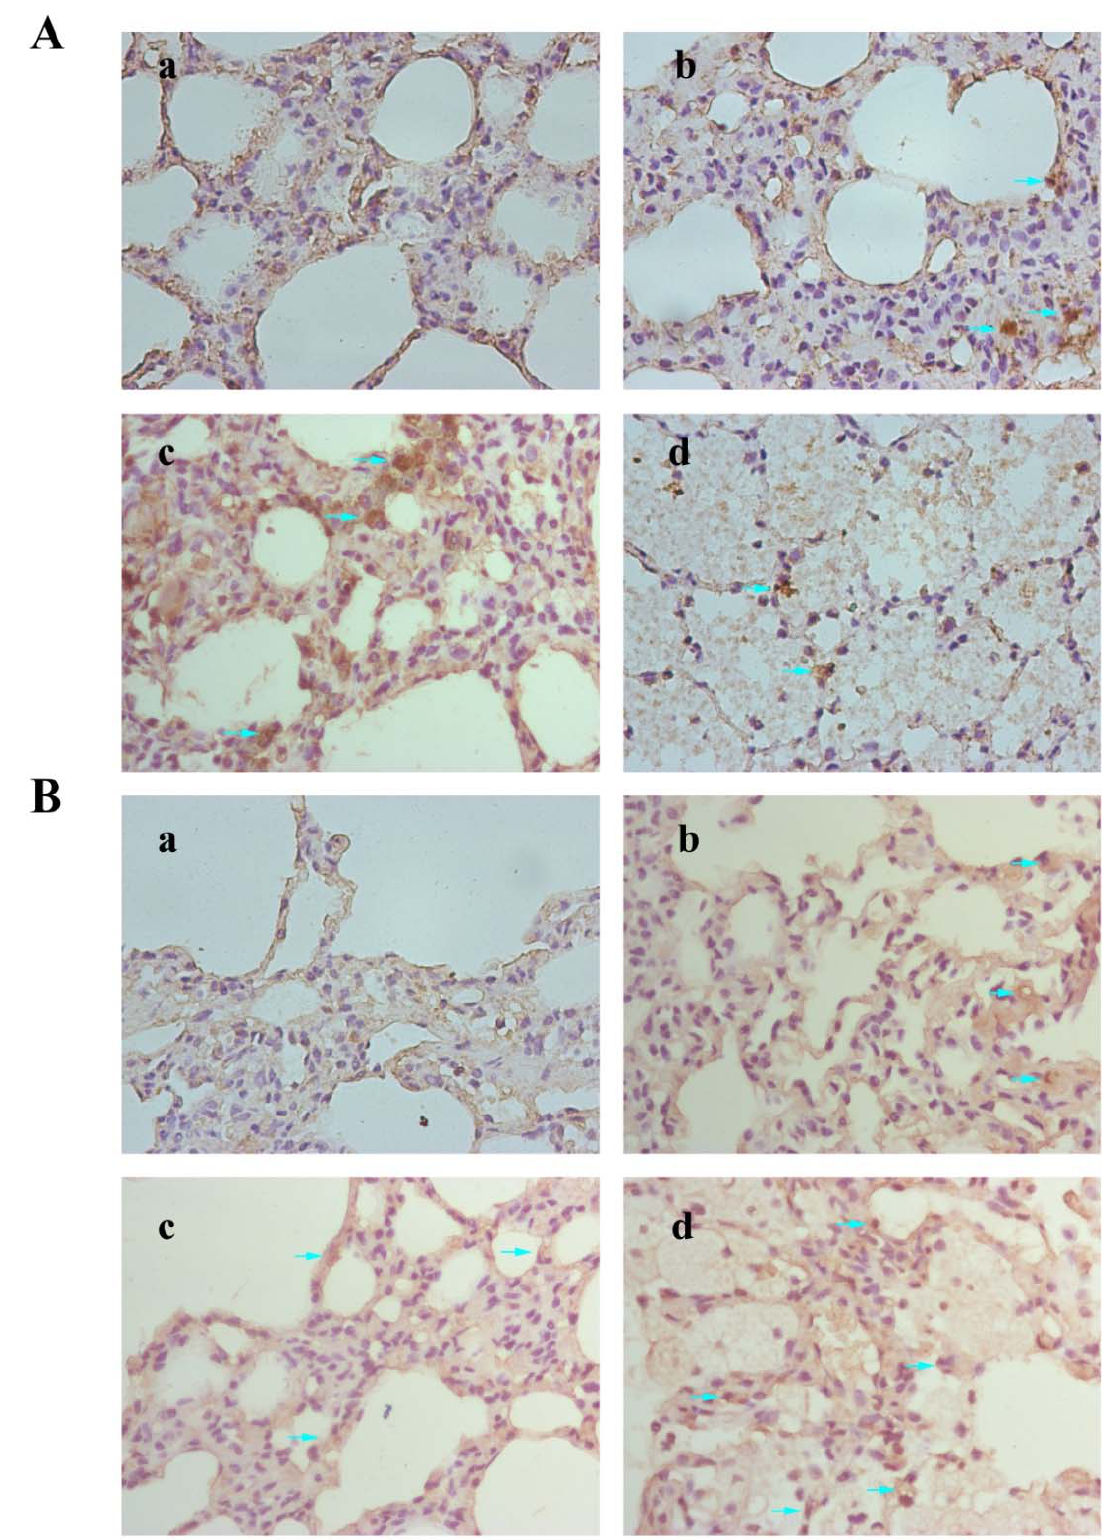
Figure 8. Expressions of Bax ( A ) and Bcl-2 ( B ) in rat lung were detected by immunohistochemical staining. These images were taken at 400 × magnification for the control group ( a ), low-dose group ( b ), medium-dose group, ( c ) and high-dose group ( d ). Arrows indicated the positive cells.